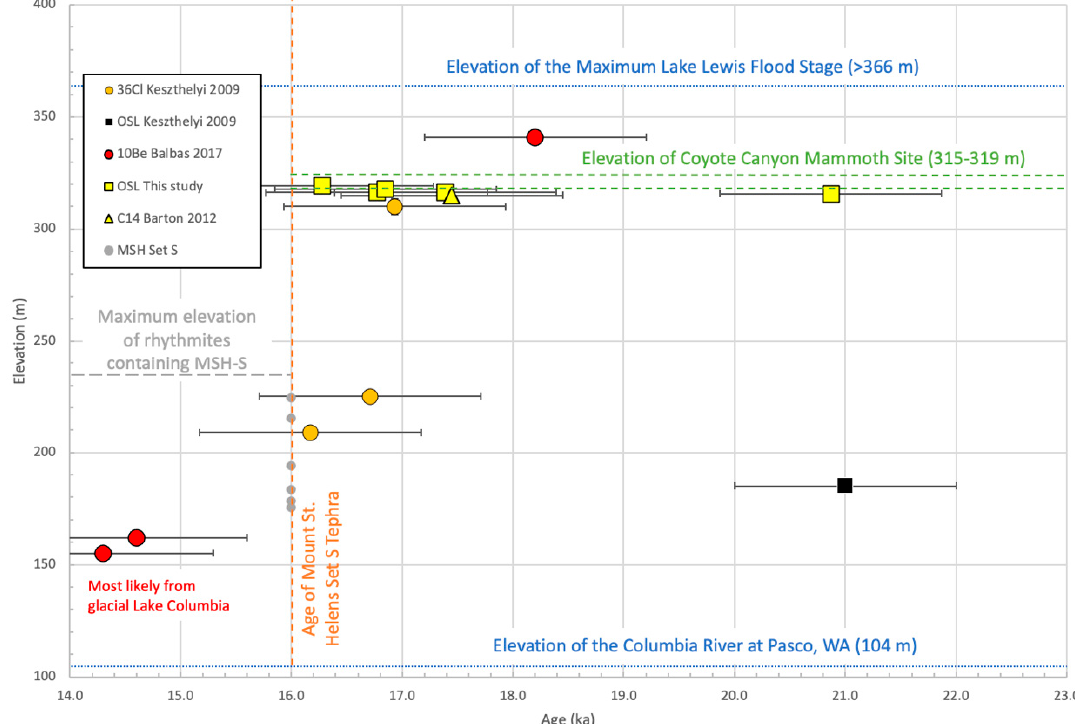
Figure 9. Graph of OSL and radiocarbon ages from the Coyote Canyon area (in yellow) compared with other available ages for Missoula flood deposits (rhythmites and erratics) from the main body of Lake Lewis (within the Pasco Basin), relative to their elevations.